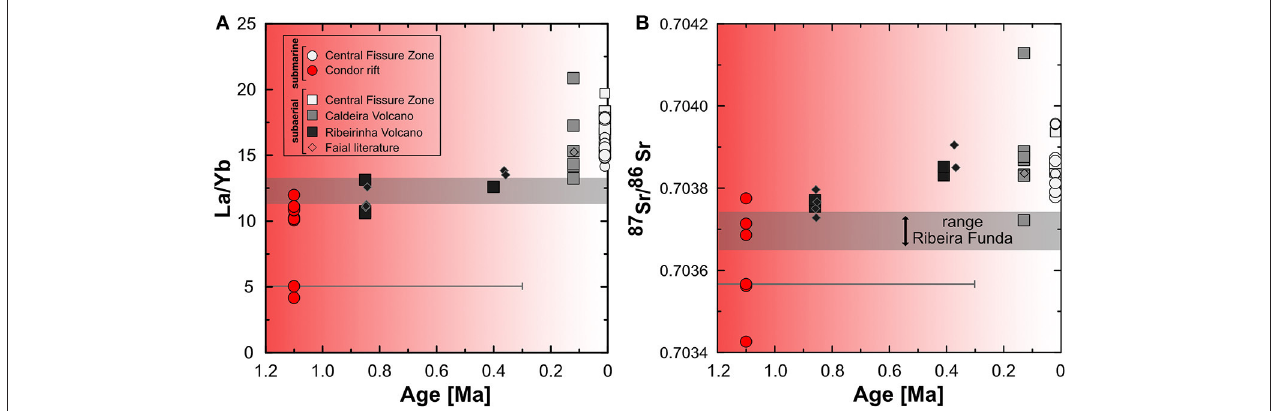
FIGURE 10 | (A) La/Yb and (B) 87 Sr/ 86 Sr vs. absolute (Madeira et al., 1995; Hildenbrand et al., 2012; Beier et al., 2015) and relative ages from seismic profiles of Faial lavas and respective rift zones. La/Yb and 87 Sr/ 86 Sr ratios display both a progressive decrease in the degree of partial melting and a progressive enrichment of the mantle source compositions. Color gradient schematically illustrates the progressive change in the melting regime from a more depleted mantle source and high degree of partial melting (red) to a more enriched mantle source and a lower degree of partial melting (white) (see also Figure 11 ). Gray area marks the range La/Yb and 87 Sr/ 86 Sr ratios of the Ribeira Funda rift lavas. Error bars display the analytical variation in Ar-Ar age form the submarine Condor rift. The analytical errors of the other absolute, radiometric ages are smaller than the respective symbols. Note that the lower La/Yb and 87 Sr/ 86 Sr for those lavas compared to the Caldeira Volcano may indicate that this rift zone is older. Literature data are from Hildenbrand et al. (2014) for La/Yb and 87 Sr/ 86 Sr. The respective ages derive from K-Ar age dating from Hildenbrand et al. (2012) on the same rock specimen like on which the trace element and isotope analysis were carried out. Symbols are maximum radiometric ages from the respective volcanic units.